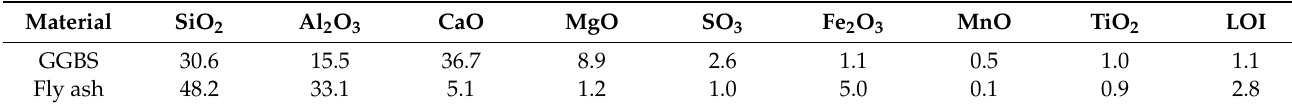
Table 1. Chemical composition of cementitious materials (wt.%).